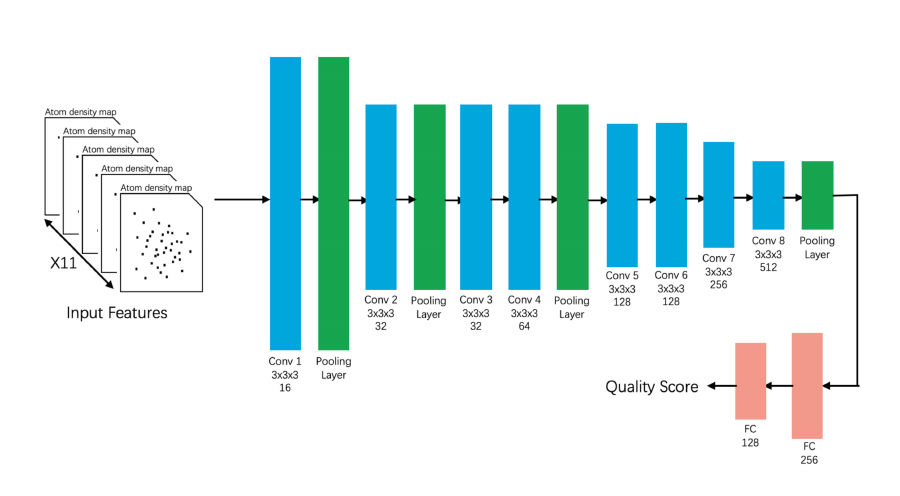
Figure 5. The convolutional neural network structure of